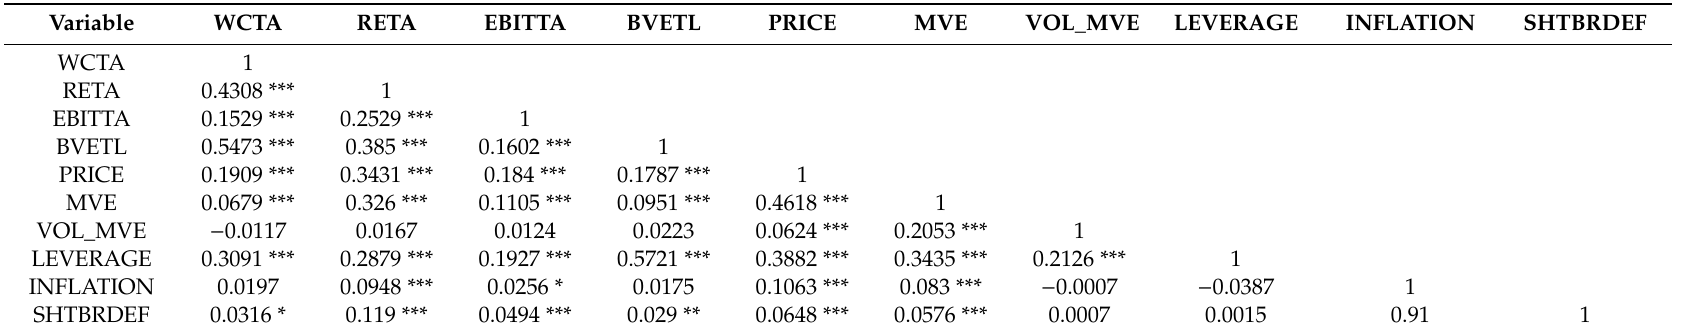
Table A2. Correlation matrix post crisis,